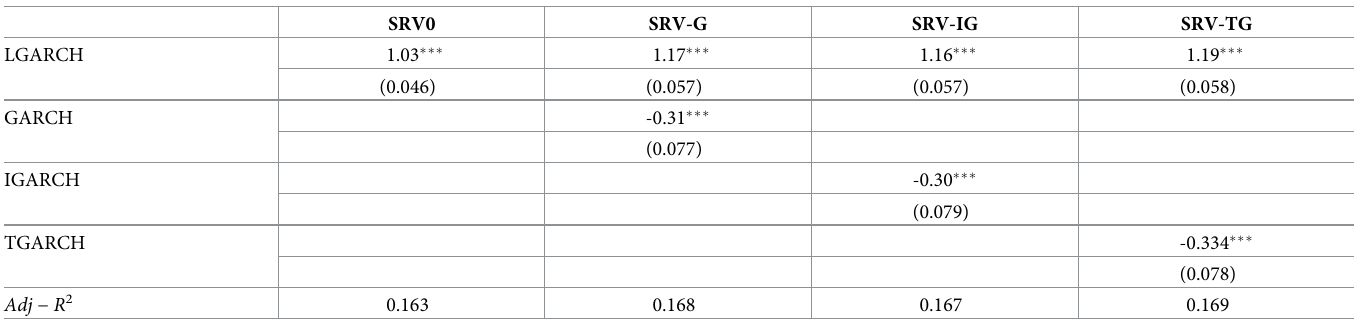
Table 7. Regression results for simplified realized variance (in-sample). This table reports the Mincer-Zarnowitz regression result for the model performance compari- son regarding the in-sample simplified realized variance. SRV0 represents the single variable regression for our model only, SRV-G represents the model 1 is our model and model 2 is GARCH model defined in Eq (12); SRV-IG represents the model 1 is our model and model 2 is IGARCH model defined in Eq (12); SRV-TG represents the model 1 is our model and model 2 is TGARCH model defined in Eq (12). � , �� , ��� indicate statistical significance at 10%, 5% and 1% levels,